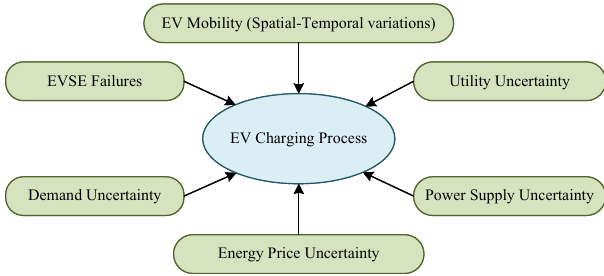
Figure 1. Uncertain aspects for EV charging process [31].